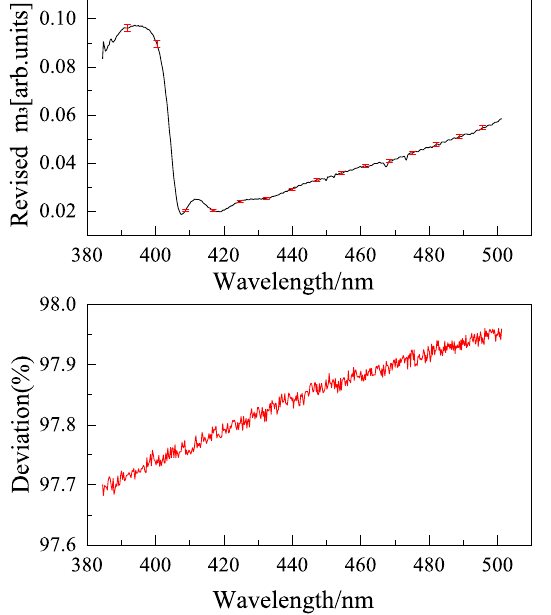
Figure 20. Comparison of Mueller matrix element m 3 for channel 2 before and after correction for UV hyperspectral